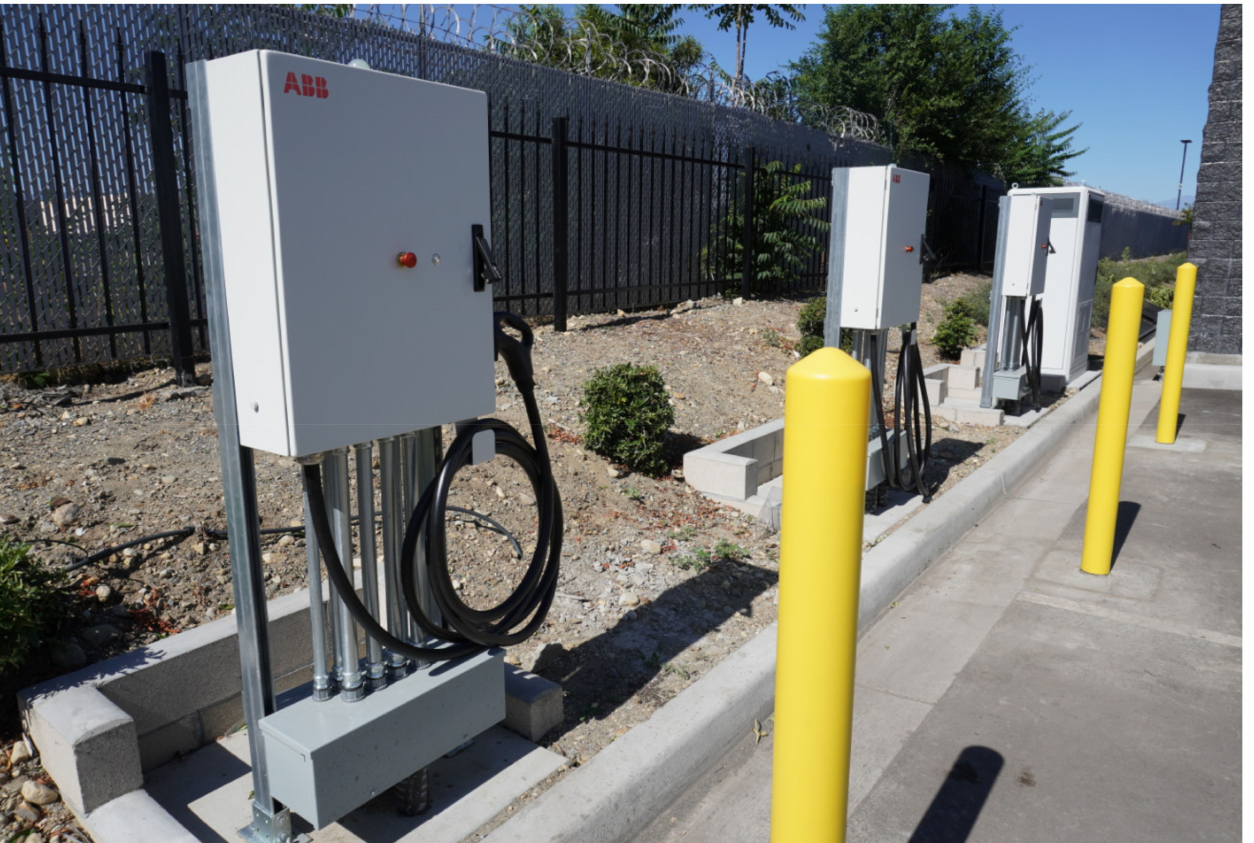
Figure 5. An example of outdoor charging